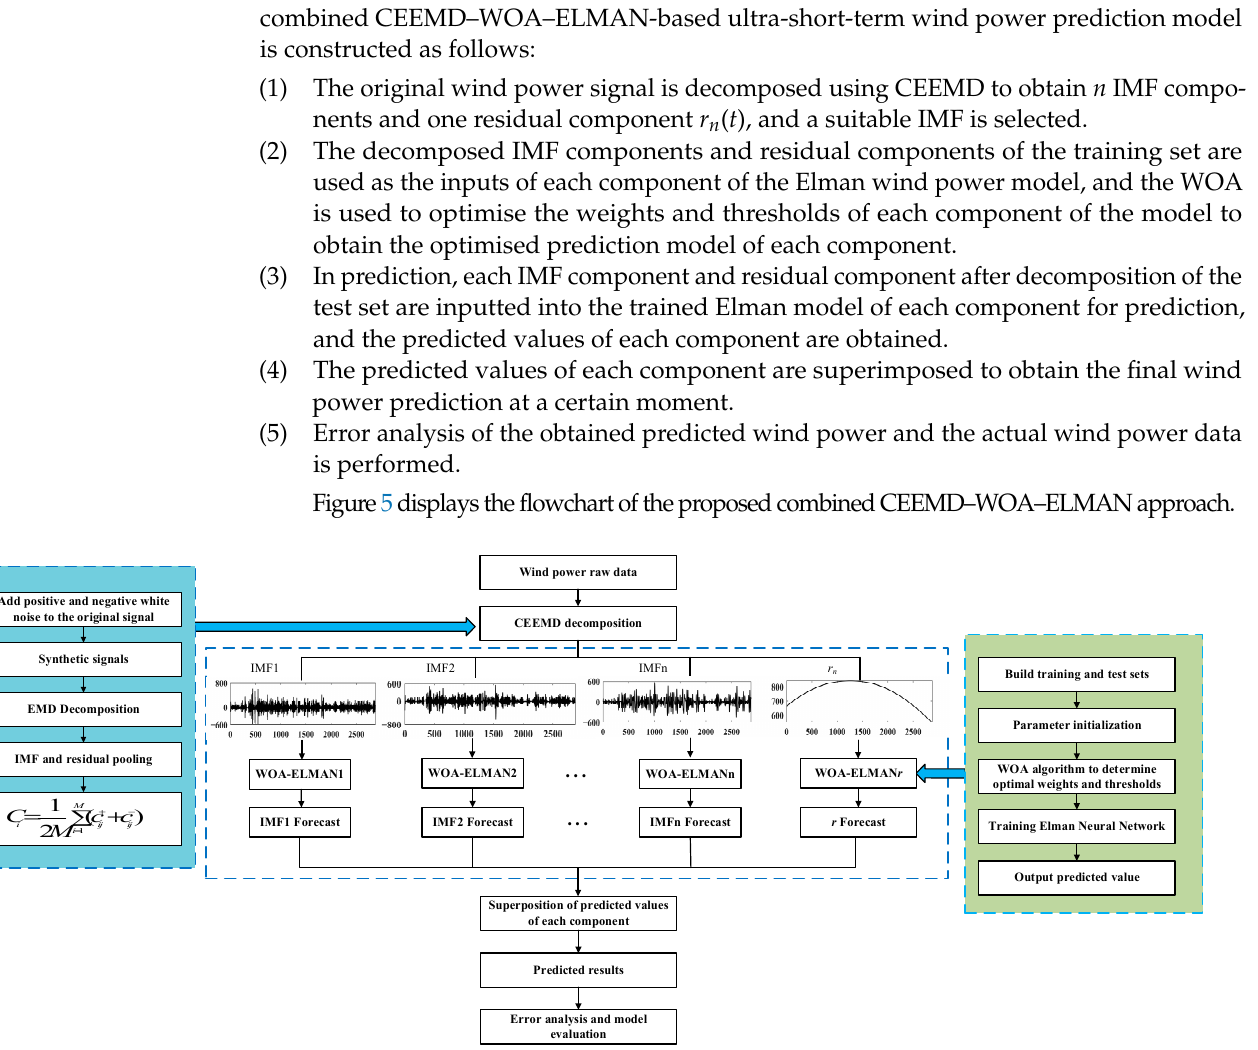
Figure 5. Flowchart based on the combined CEEMD–WOA–ELMAN method.